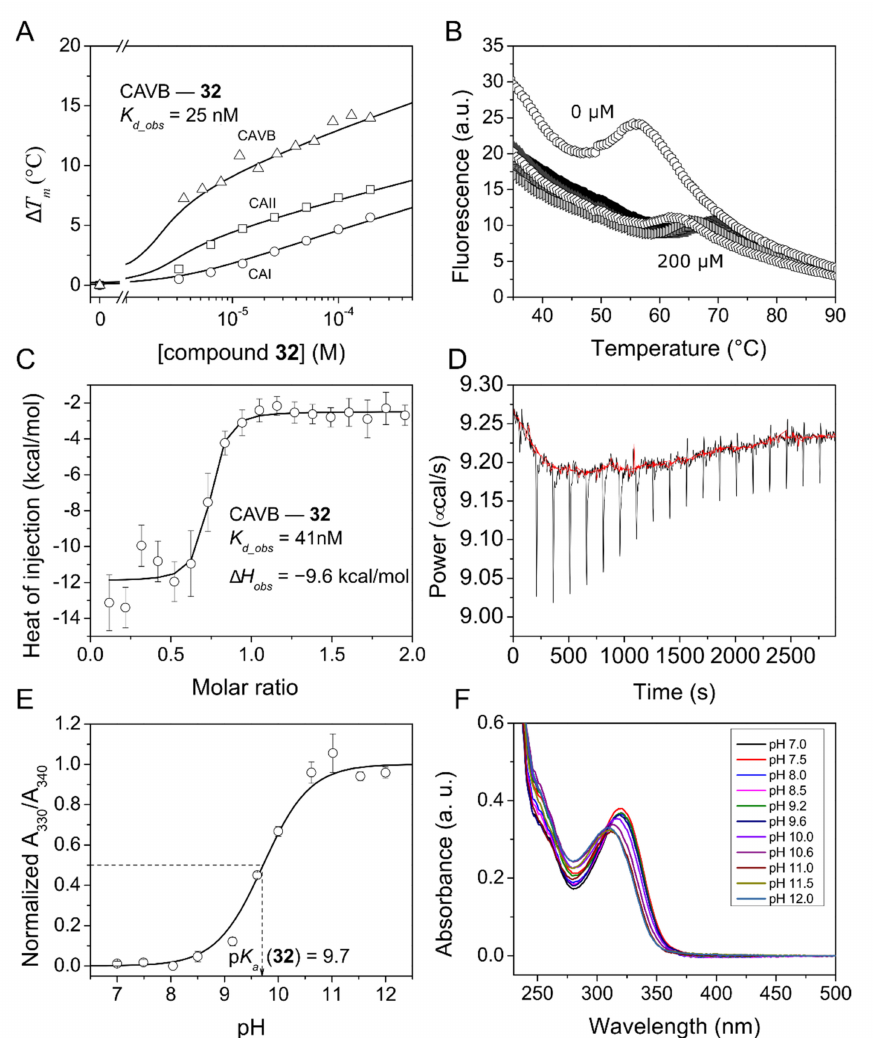
Figure 2. Fluorescent thermal shift assay (FTSA) data of compound 32 binding to CAI, CAII, and CAVB (panels ( A , B ), raw data only of CAVB) and isothermal titration calorimetry (ITC) data of compound 32 binding to CAVB (panels ( C , D )). Dissociation constant, K d_obs , values at 37 ◦ C and pH 7.0 in 50 mM sodium phosphate buffer containing 100 mM NaCl are shown near the corresponding graphs in panels ( A , C ). To calculate the intrinsic dissociation constants, the p K a values of compound sulfonamide group were measured spectrophotometrically at 37 ◦ C (panels ( E , F )). The normalized absorbances at selected wavelengths were plotted as a function of pH and fitted to the Henderson– Hasselbalch equation. Table 2. The observed dissociation constants of all 12 catalytically active CAs with tested compounds at pH 7.0 and 37 ◦ C by the fluorescent thermal shift assay. The value ≥ 200,000 is the upper limit of K d_obs detection; ND– K d_obs value was not determined. The standard deviation of the FTSA measurements is ± 1.6-fold in K d_obs . The ITC data are shown in the brackets (pH 7.0, 37 ◦ C).